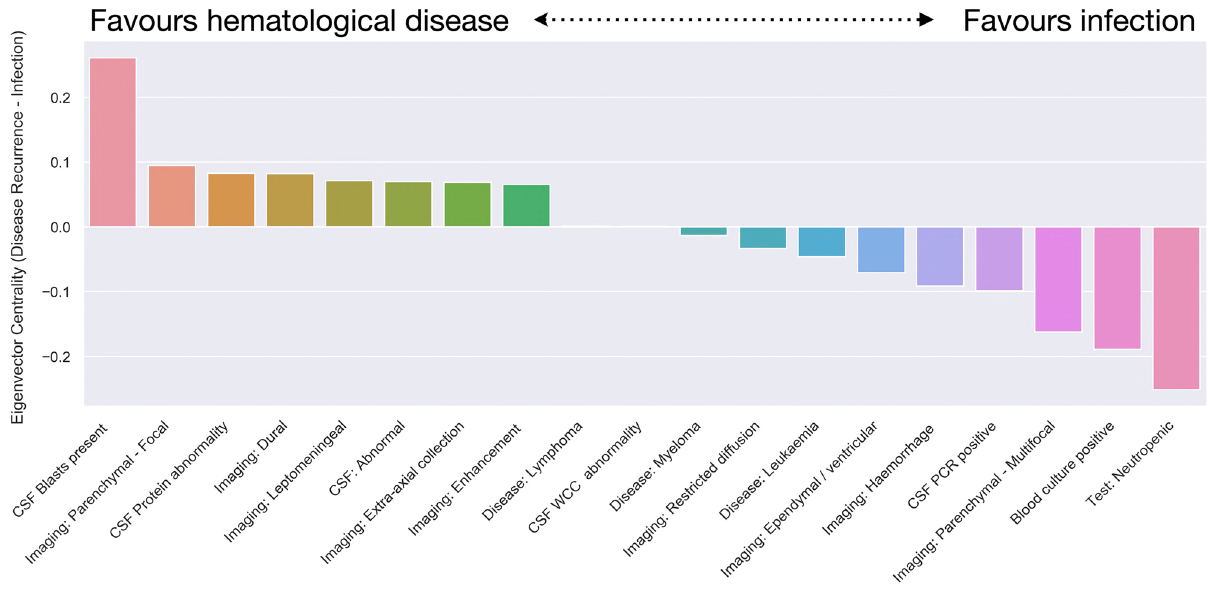
Figure 3. Quantitative graphical centrality differences of diagnostic features between CNS hematological disease involvement and infection. Absolute difference in the normalized eigenvector centrality of features, weighted by directed conditional probability. Features with value above zero (left side of bar plots) favor the CNS hematological disease involvement group and features with value below zero favor the CNS infection group (right side of bar plots). CSF cerebrospinal fluid, PCR polymerase chain reaction, WCC white cell